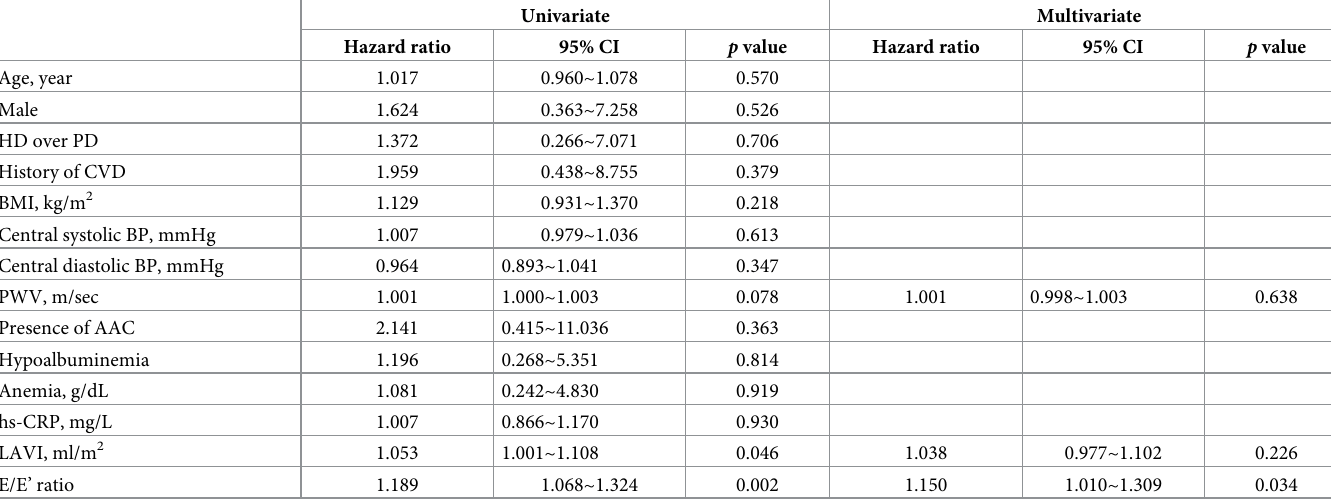
Table 2. Cox regression analysis of proportional hazard for CV mortality.